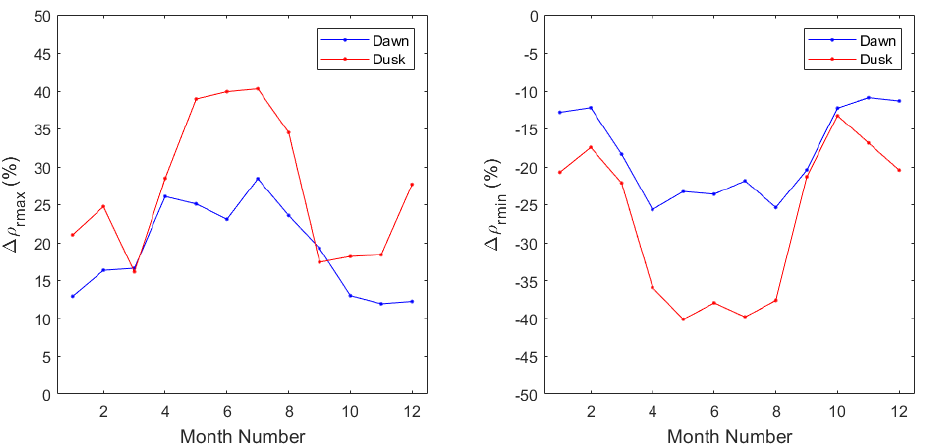
Figure 5. Seasonal variation of Δ ρ rmax ( left ) and Δ ρ rmin ( right ) at dawn and dusk from APOD. The blue and red lines denote the dawn and dusk sectors. blue and red lines denote the dawn and dusk